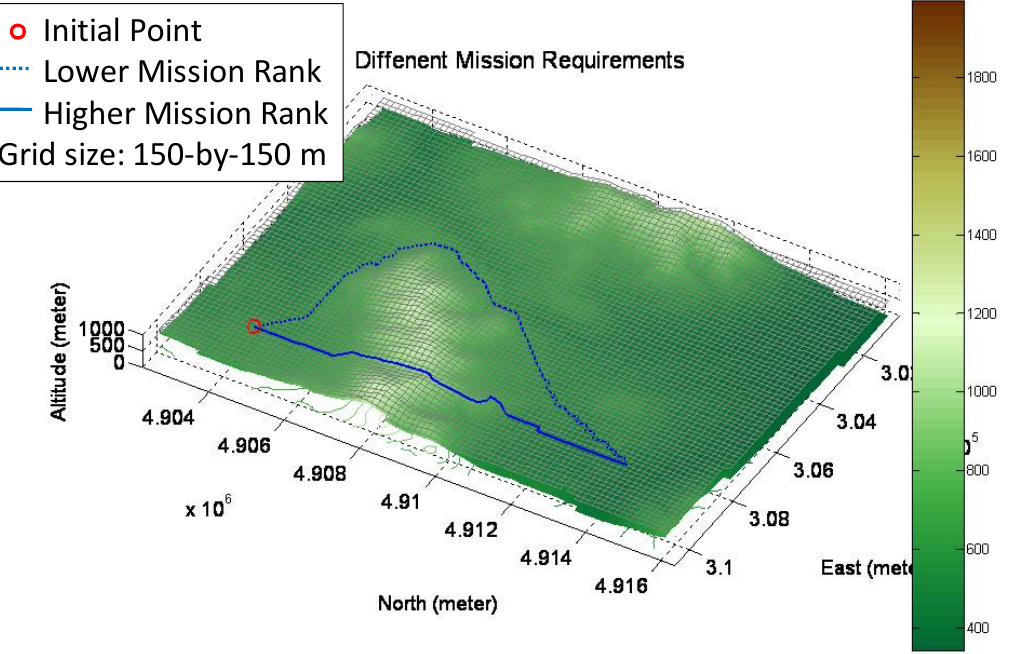
Figure 5. Two flight paths are planned according to the different mission